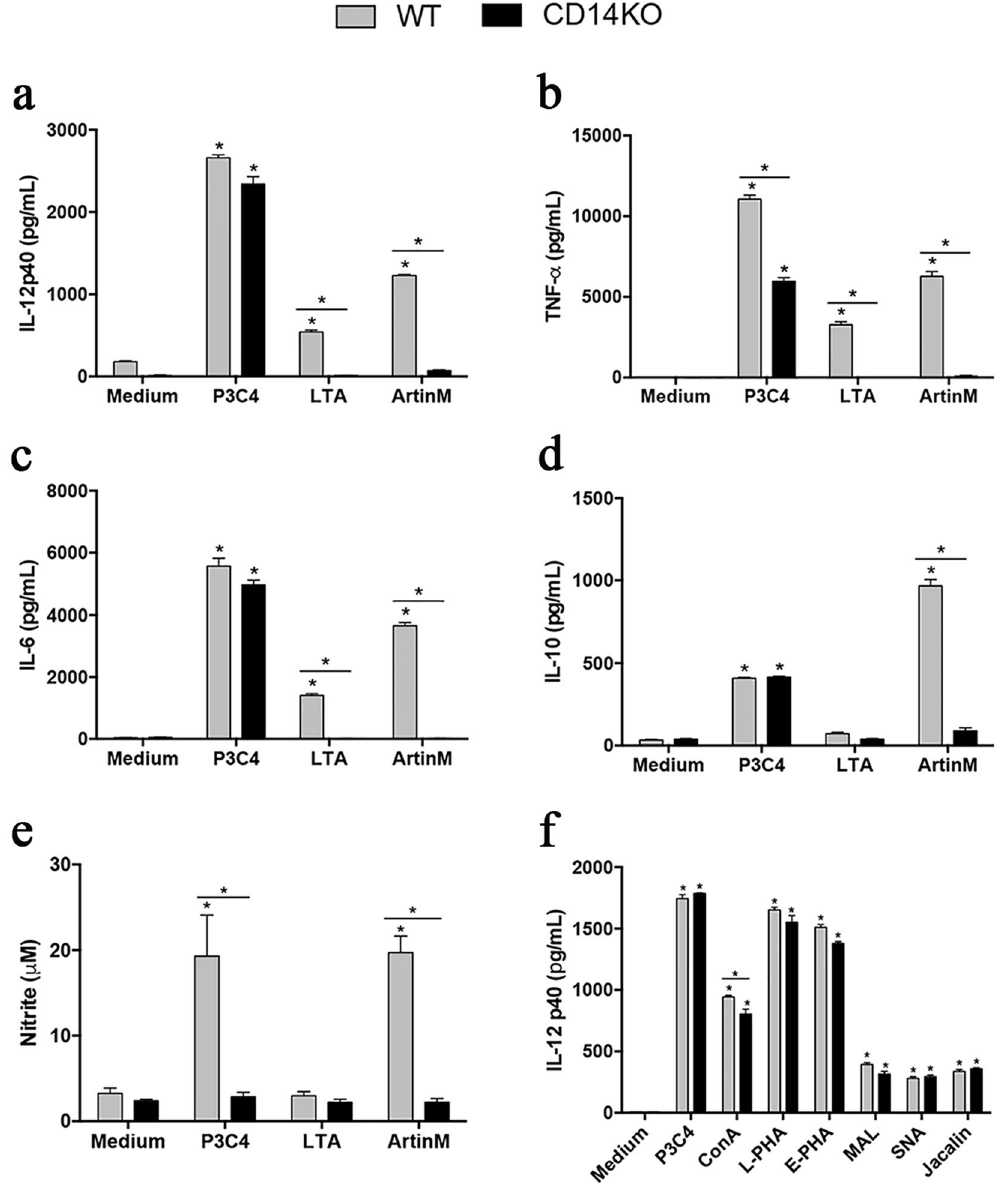
Figure 1. Influence of the absence of the CD14 in pro-inflammatory mediators production by ArtinM- stimulated macrophages. Macrophages (2 × 10 6 /mL) from wild-type (WT) and CD14 knockout (KO) mice were stimulated with ArtinM (2.5 µ g/mL), Concanavalin A (ConA; 10 µ g/mL), Phytohemagglutinin-L (L-PHA; 10 µ g/mL), Phytohemagglutinin-E (E-PHA; 10 µ g/mL), Maackia amurensis lectin (MAL; 10 µ g/mL), Sambucus nigra lectin (SNA; 10 µ g/mL), Jacalin (10 µ g/mL), palmitoyl-3-cysteine-serine-lysine-4 (P3C4; 1 µ g/mL), lipoteichoic acid (LTA; 1 µ g/mL) or medium for 48 h. Culture supernatants were assessed by ELISA for levels of IL-12p40 ( a and f ), TNF- α ( b ), IL-6 ( c ), IL-10 ( d ), and nitrite ( e ). The values (in pg/mL or µ M) in WT and CD14 KO macrophages were compared with those of cells in medium; results provided by WT and CD14 KO macrophages stimulated with ArtinM, P3C4, or LTA were also compared. Data are shown as means ± SEM of independent experiments. * p < 0.05; one-way analysis of variance followed by Bonferroni’s